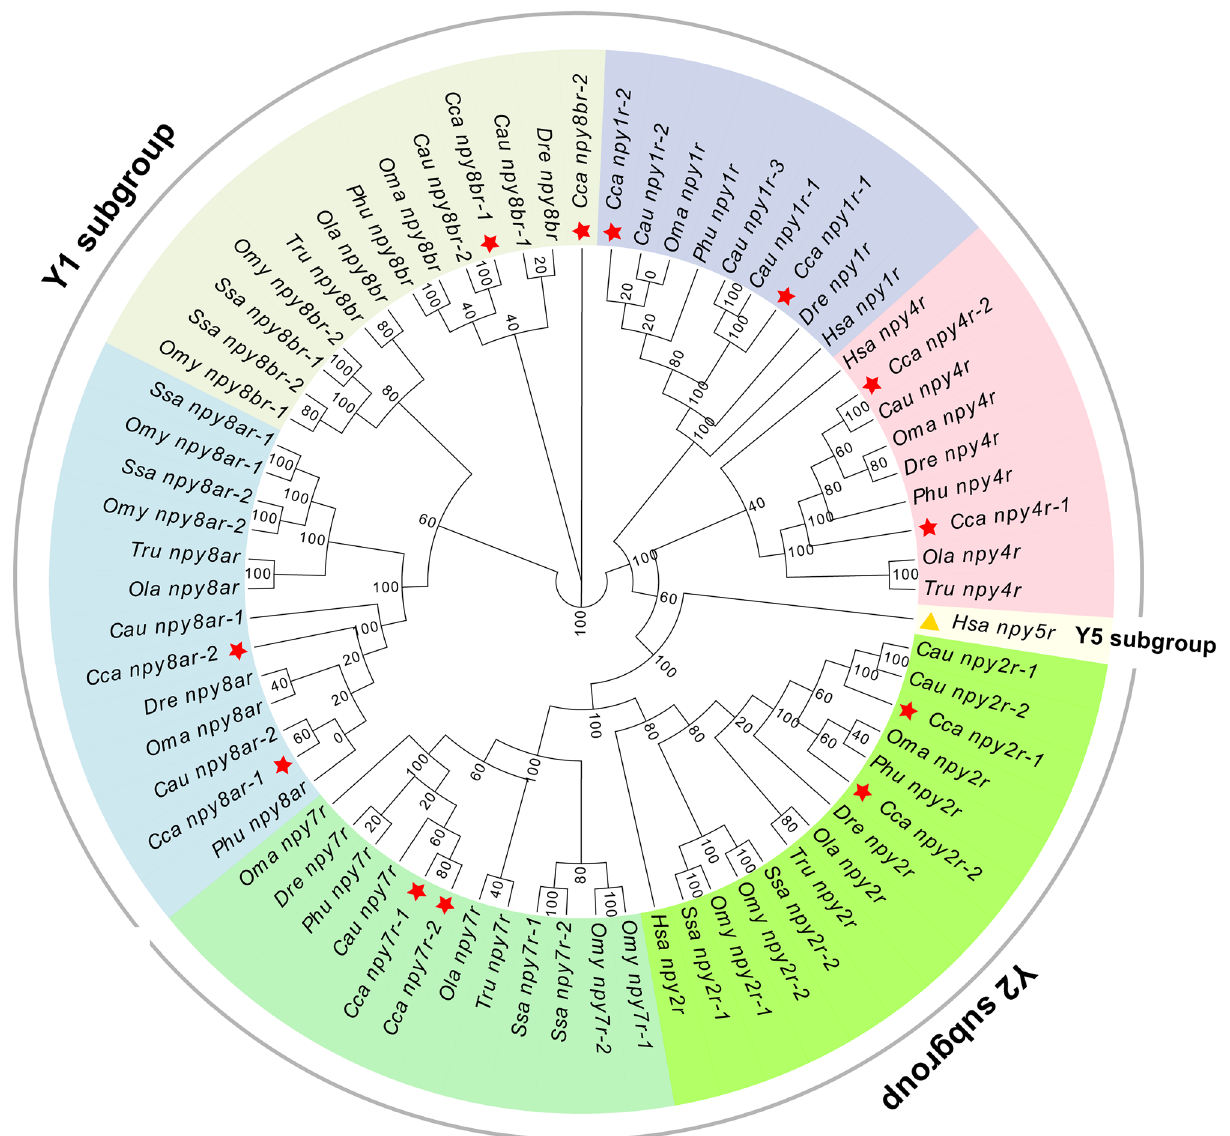
Figure 2. Phylogenetic tree of the NPY-family receptors in vertebrates. All of the same types of NPY-family receptors are shown to have the same color backgrounds as the NPY-family receptors of common carp that are marked by red stars. The one marked with a triangle is NPY5R, which is used as an outgroup of the phylogenetic tree. Abbreviations for species names: Homo sapiens (Hsa), Danio rerio (Dre), Salmo salar (Ssa), Oncorhynchus mykiss (Omy), Oryzias latipes (Ola), Poropuntius huangchuchieni (Phu), Onychostoma macrolepis (Oma), Cyprinus carpio (Cca), Takifugu rubripes (Tru), Carassius auratus (Cau).